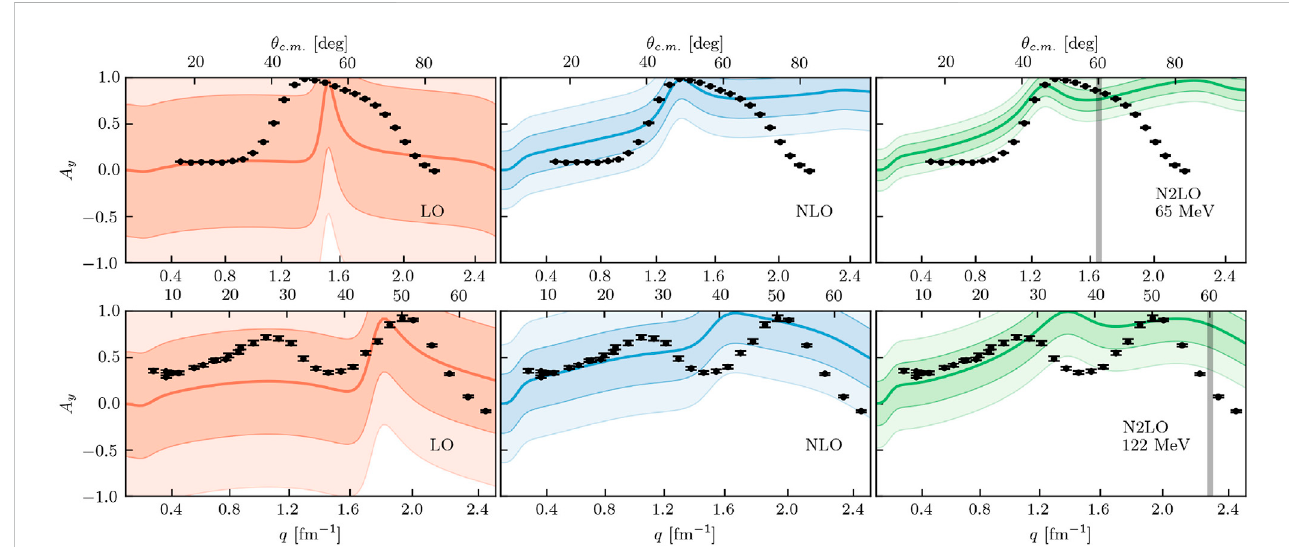
FIGURE 7 Analyzingpowerforprotonscatteringon 12 Cat( fi rstrow)65 MeVand(secondrow)122 MeVforLO(leftcolumn),NLO(middlecolumn),andN2LO(right column) with corresponding 1 σ (darker bands) and 2 σ (lighter bands) error bands. Black dots are experimentaldata from Ref. [84](65 MeV) and [83] (122 MeV). Figure taken from Ref.